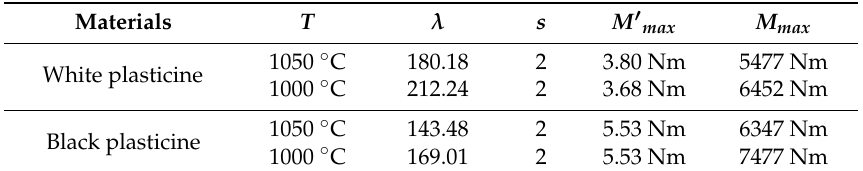
Table 6. Extrapolation of the maximum moments in helical rolling of 57 mm diameter balls, based on test results of the model